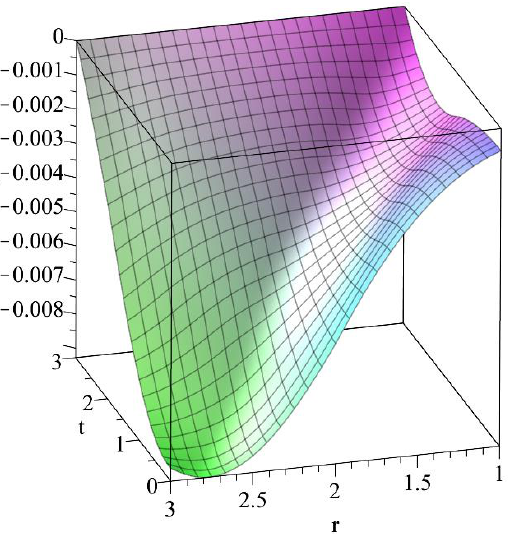
Figure 13. The distribution of the dynamic temperature increment in the context of the hyperbolic two-temperature model when D = 0.2.